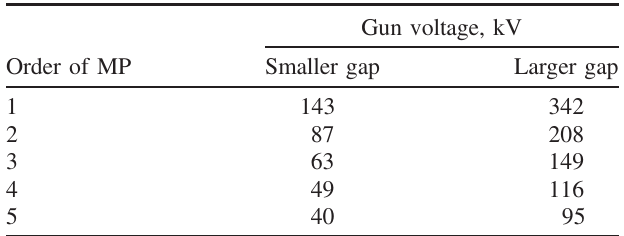
TABLE II. Analytical estimations in the stalk gap.